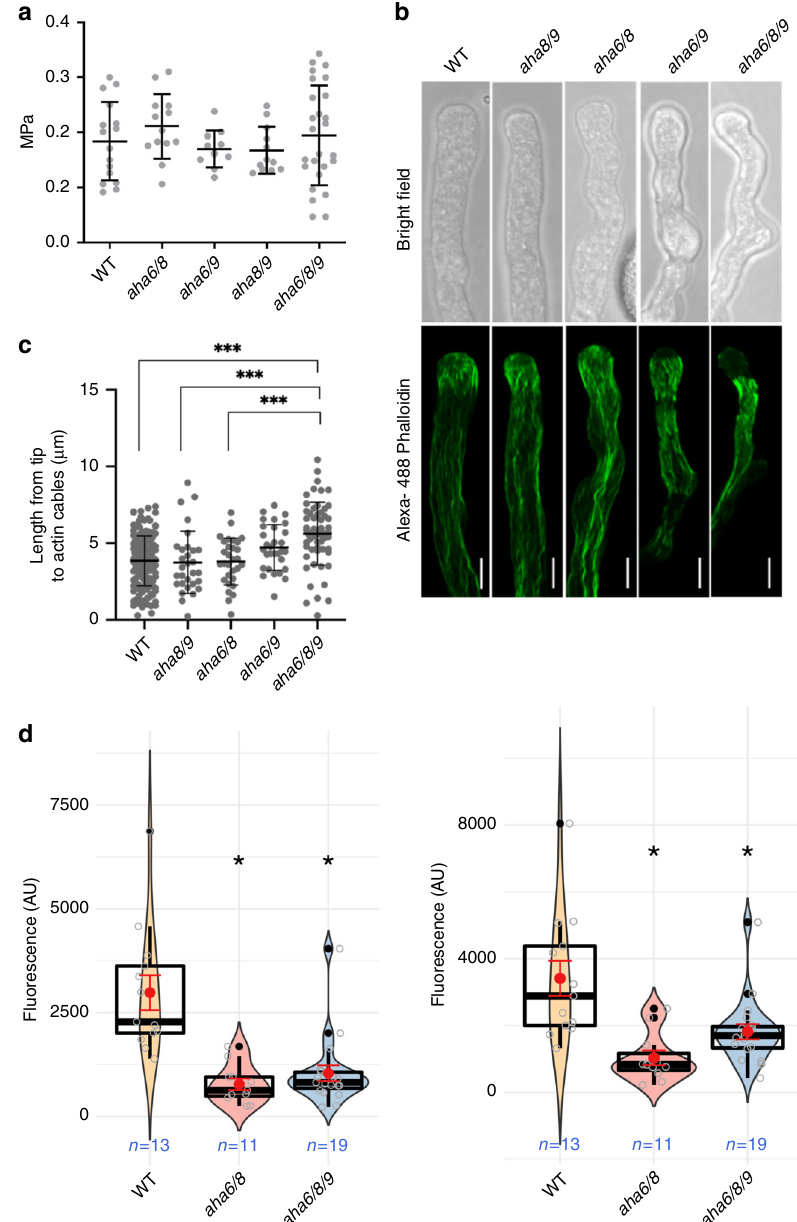
Fig. 5 Turgor pressure is unaltered in aha6/8/9 pollen tubes, but actin is located away from the tip and membrane potential is reduced. a Turgor pressure in WT and AHA mutant pollen tubes (one-way ANOVA and Bonferroni ’ s Multiple Comparison Test; p < 0.01; error bars show mean with SD). b Actin in pollen tubes was stained with Alexa 488 phalloidin and images were obtained using a confocal laser scanning microscope. Fluorescence and bright- fi eld images were generated by maximum intensity projections of all optical sections for each pollen tube using ImageJ software (scale bars = 5 µ m). c The distance from the tip of the pollen tube to the actin fi laments in pollen tubes. Where applicable, asterisks indicate a signi fi cant difference compared to the control (WT); ANOVA with Bonferroni ’ s test; p < 0.01; error bars show mean with SD. d Quanti fi cation of plasma membrane potential using ANNINE- 6-plus 10 – 20 µ m (left panel) and 40 – 50 µ m (right panel) from the tip, respectively. Violin plots show the probability density with color- fi lled curves obtained from individual observations (open gray circles), with boxplots (thick black lines and outliers as black dots) overlaid with mean and standard error (red circle and lines). Membrane fl uorescence values were quanti fi ed using a customized protocol, including near super-resolution, Nyquist oversampling and normalization between replicates (Suppl. Fig. 12). Differences were signi fi cantly lower in all mutants than in wild-type, but no signi fi cant differences were found within mutants at either domain of the plasma membrane sampled (see Suppl. Fig. 12 for details) (scale bars = 2 µ DNA was ampli fi ed by Phusion high- fi delity DNA-polymerase (NEB) using the inserts were subsequently transferred into the pMDC99 destination vector 70 . The same forward primer as used for cloning the GFP constructs, and reverse primers resulting expression vector was then introduced into the aha6/8 double complementary to sequences in the second exon of the respective gene (Supple- mutant line. mentary Table 3). The resulting PCR products were cloned into pENTR/D-TOPO vectors (Invitrogen) by TOPO cloning, according to the manufacturer ’ s instruc- tions, and the inserts were fully sequenced. Using LR recombinase (Invitrogen), the inserts were subsequently transferred into the pMDC162 destination vector 70 .